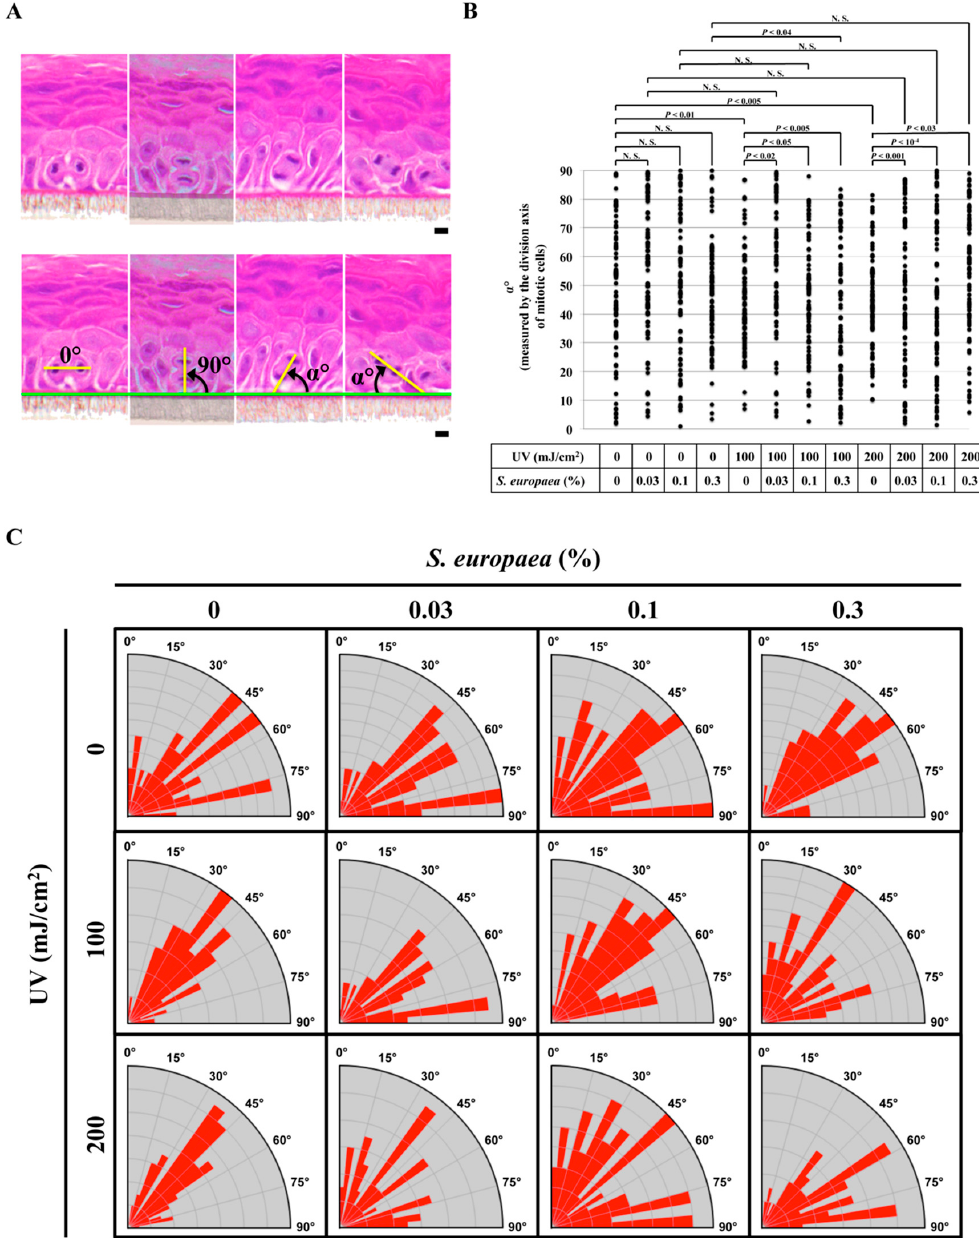
Figure 3. Improvements in the directional cell division of UVB-exposed epidermal cells located at the basal layer, after treatment with S. europaea. ( A ) Angle definition of cell divisions in suprabasal keratinocytes. Light microscopic images of the cross section of hematoxylin-eosin-stained mitotic suprabasal keratinocytes in a multilayered, highly di ff erentiated in vitro skin model are shown in the upper panels. Here, we defined the angles for quantitatively characterizing the orientation of the axis of cell division in mitotic basal keratinocytes as shown in the lower panels. Scale bar, 10 µ m. ( B ) Dot plot of the division angle ( α ◦ ) of suprabasal keratinocytes. Each symbol in the dot plot represents the angle measured from three di ff erent experiments each, observed in over twenty-five metaphase cells (total 80 observations). UVB-irradiated or non-irradiated keratinocytes were treated with di ff erent concentrations of S. europaea, as indicated. The variance of α ◦ was found to be not significantly di ff erent between unexposed, untreated cells and unexposed, S. europaea -treated cells. On the other hand, the variance of α ◦ was significantly di ff erent among the unexposed cells and UVB-exposed cells and among the unexposed and untreated cells and UVB-exposed, S. europaea -treated cells. ( C ) Rose plots for ( B